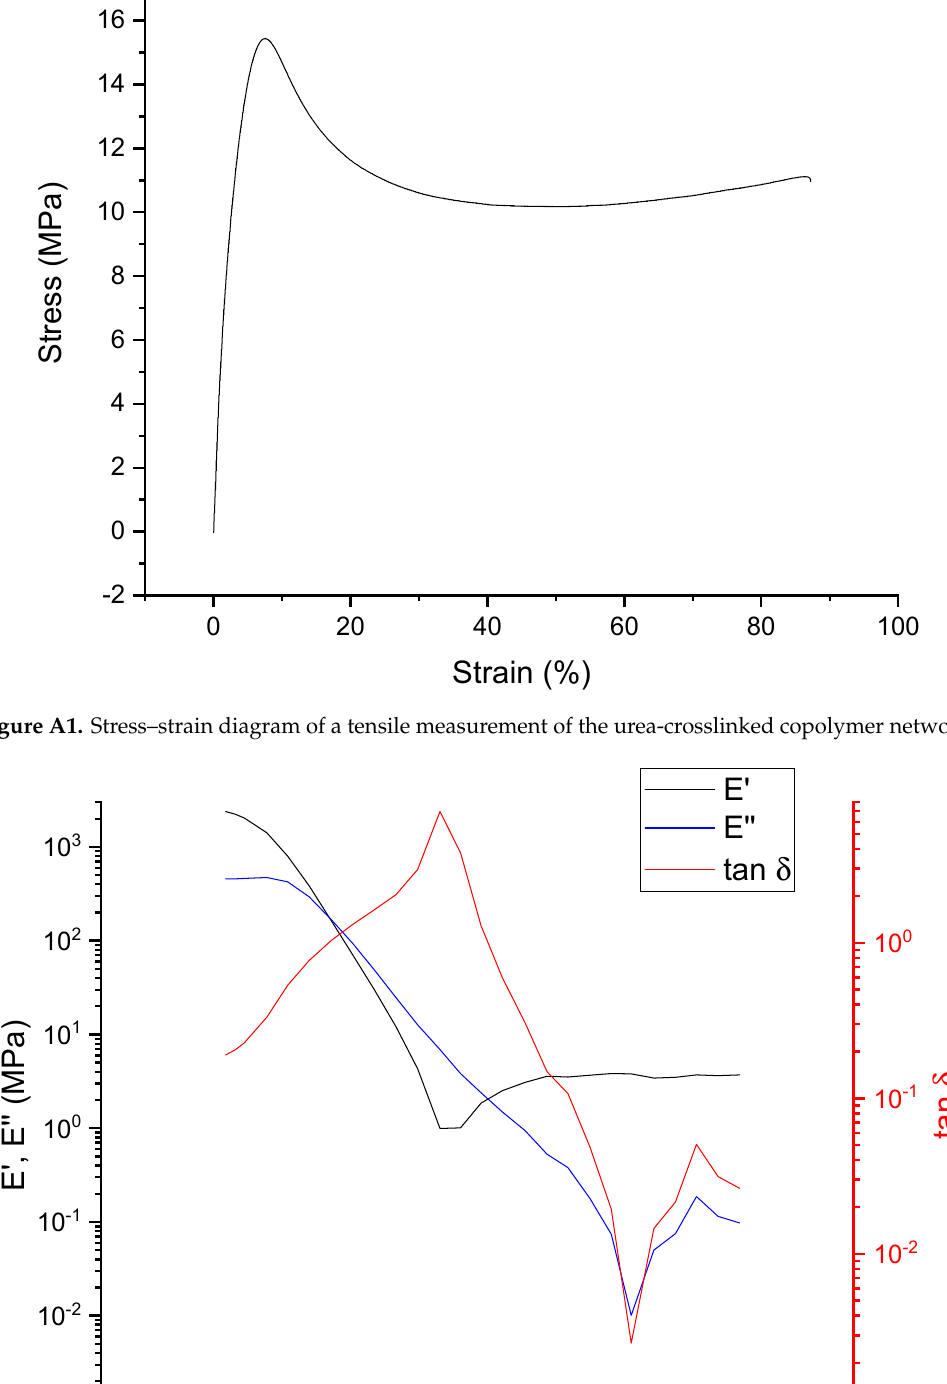
V≈ 10 mL Figure A3. Picture of the dog-bone specimen of the urea-crosslinked copolymers. The upper small dog-bone represents a DMTA sample after the sanding process. The lower larger dog-bone represents a standard tensile sample before the sanding process .